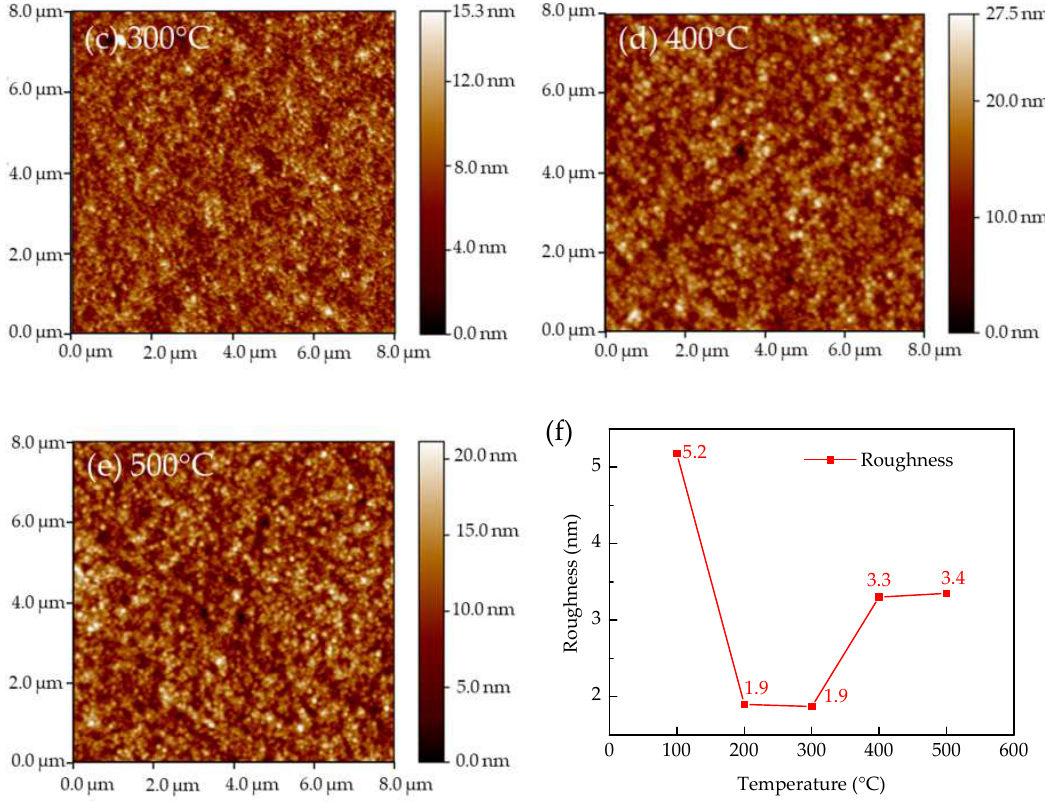
Figure 2. The atomic force microscope (AFM) images 8000 nm × 8000 nm) and the roughness of WO 3 films. ( a ) 100 °C; ( b ) 200 °C; ( c ) 300 °C; ( d ) 400 °C; ( e ) 500 °C; ( f ) the roughness of WO 3 films, which are read by the support software of AFM.